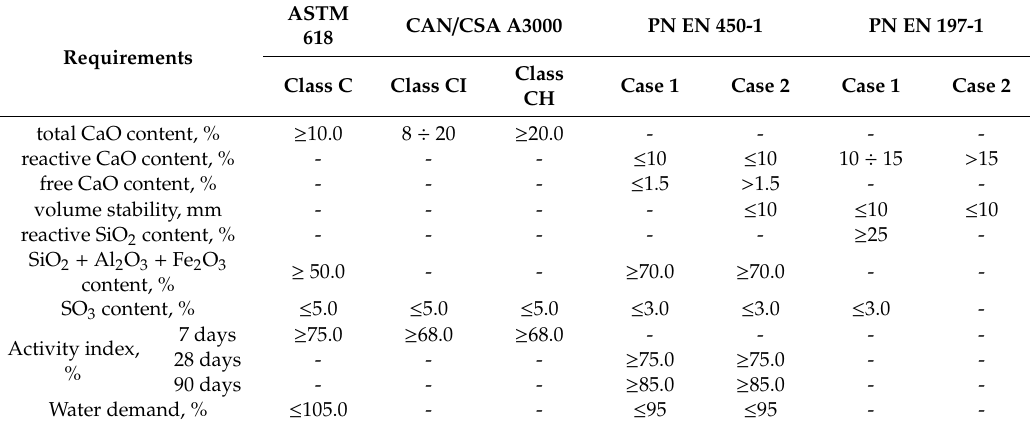
Table 1. Requirements for high-calcium (calcareous) fly ash according to di ff erent